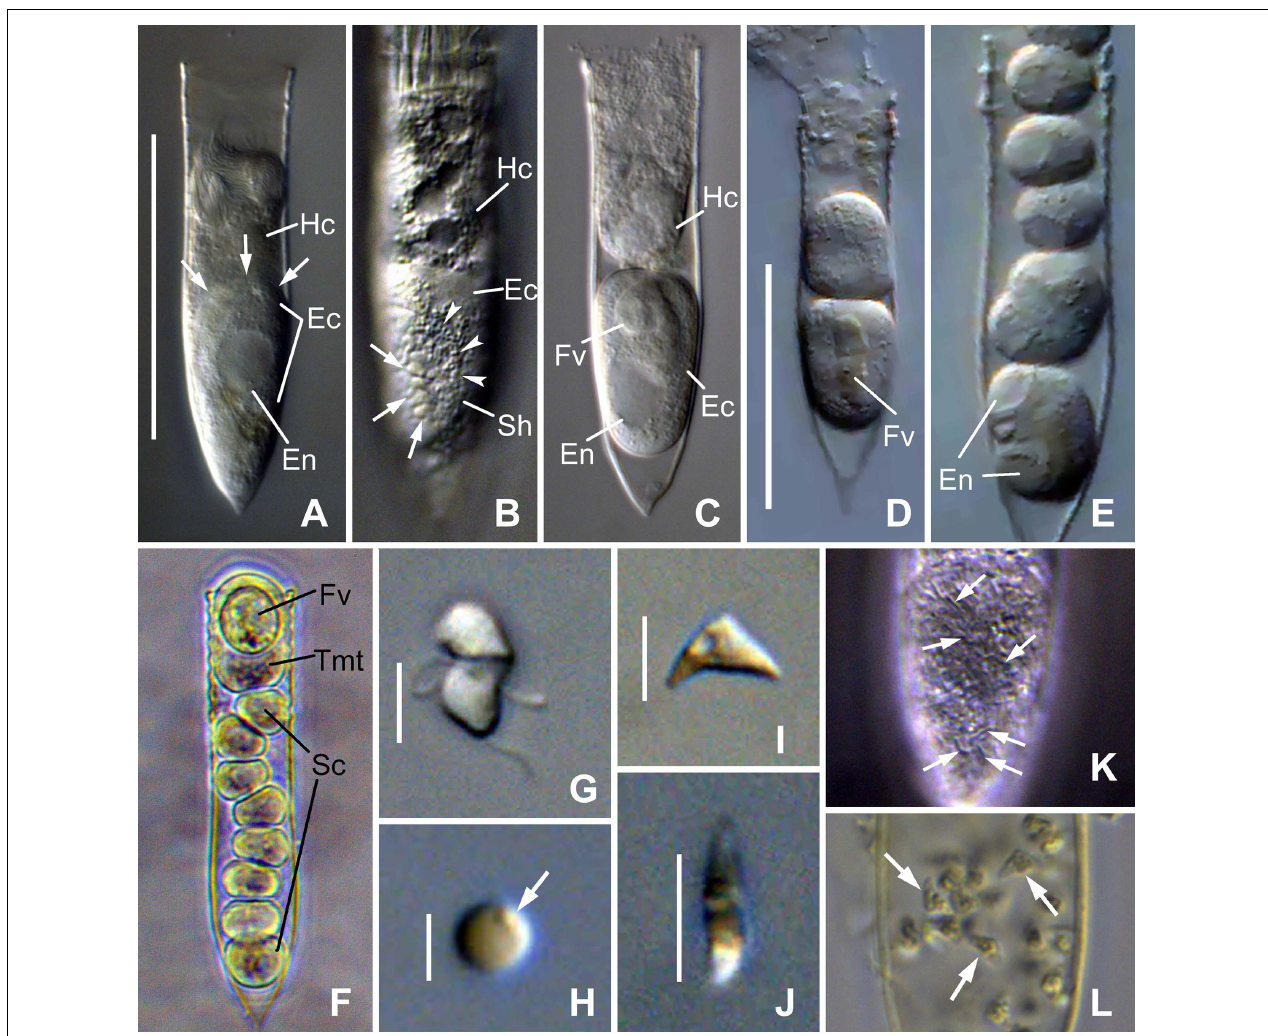
FIGURE 2 | Photomicrograph of Euduboscquella triangula n. sp. from live (A–J) , Lugol-fixed (K) , and Bouin-fixed (L) specimens. (A) Lorica containing infected host cell with a late trophont of E. triangula (arrows indicate the margins of parasite cytoplasm). (B) Trophont showing shield margins (arrowheads) with intertwining grooves (arrows). (C) Tomont emerged from host with food vacuole. (D,E) Sporogenic division. (F) One tomont and eight sporocytes resulting from different trophonts of a double infected host. (G) Mushroom-shaped dinospore. (H) Non-motile spherical spore with granule on cell surface (arrow). (I,J) Lateral (I) and apical (J) view of non-motile triangular-shaped spores. (K) Shield with intertwining grooves (arrows) in Lugol-fixed specimen. (L) Triangular-shaped spores (arrows) in host lorica from field sample fixed with Bouin immediately after collection. Ec, Euduboscquella cytoplasm; En, Euduboscquella nucleus; Fv, food vacuole;